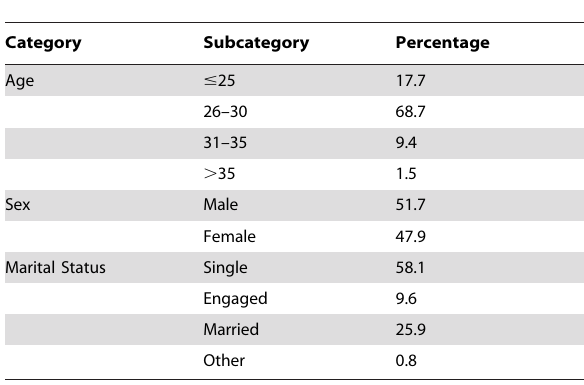
Table 1. Sample Demographic Characteristics.